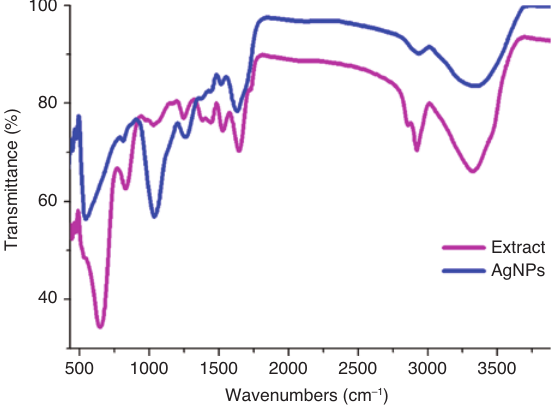
Figure 2: FTIR spectra of M. polymorpha leaf extract and synthe- sized